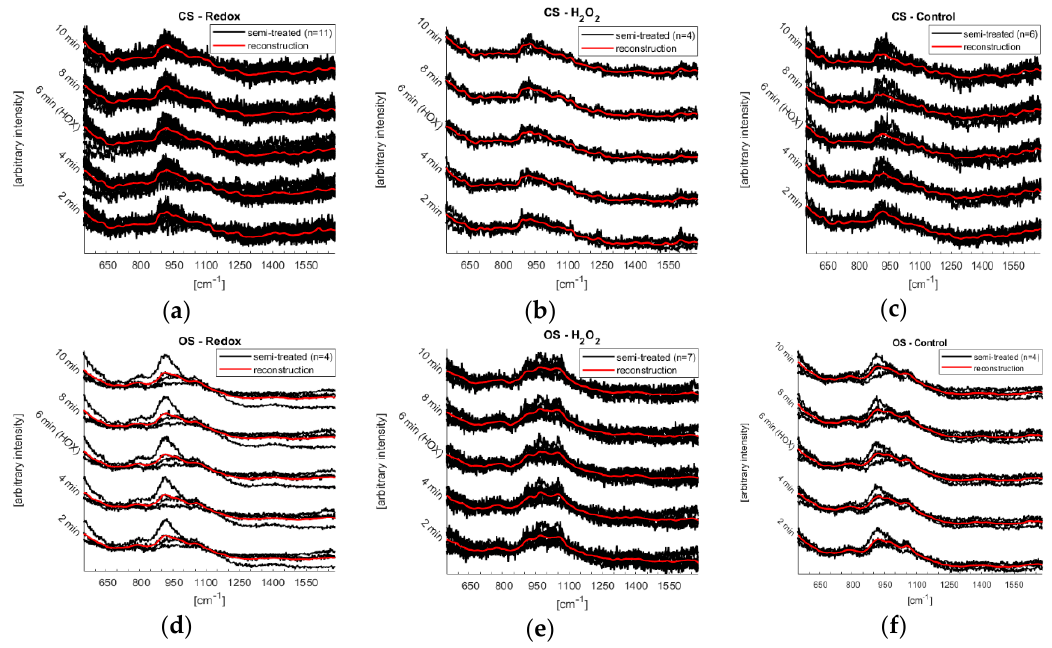
Figure 5. Reconstruction of the Raman response from measurements on PASMCs—Redox, H 2 O 2 and control. ( a – c ) are from the closed microfluidic system (CS) and ( d – f ) are from the open system (OS). The 2 min mark is the initial stage, 6 min mark is the HOX-spectra followed by recovery. The reconstructed curve (red) is placed on top of the semi-treated data (black).